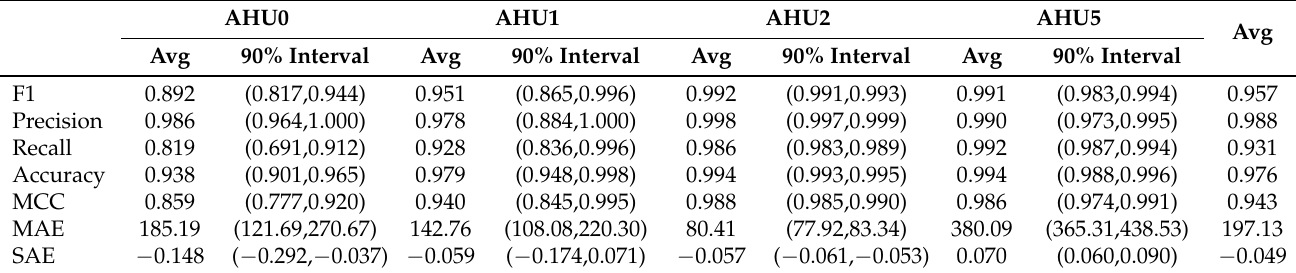
Table 6. Performance of the method in the seen scenario, including the average and 90% interval of each load over twenty experiments and the average of all